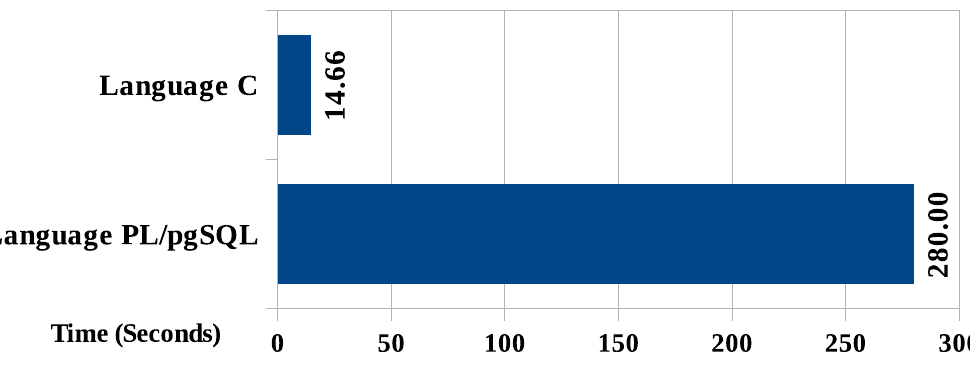
Figure 17. Response time by